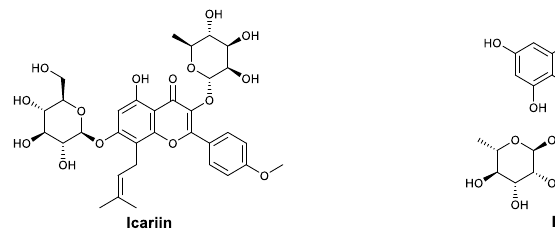
Figure 11. Structures of chlorogenic acid and phyllanthusmin C.